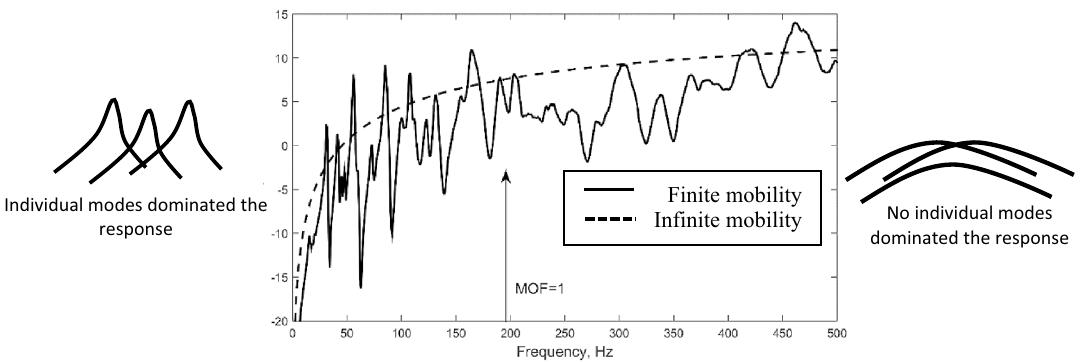
Figure 1. Typical driving point mobility of a finite rectangular plate with its infinite mobility serves as an approximation at the high-frequency range. MOF when unity is also shown 7